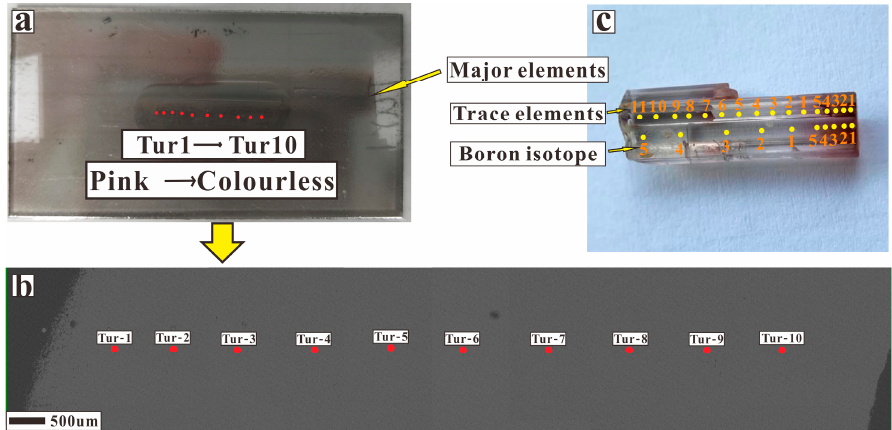
Figure 3. Spot number with its corresponding position analysed by EPMA ( a , b ), LA-ICP-MS and LA-MC-ICP-MS ( c ).